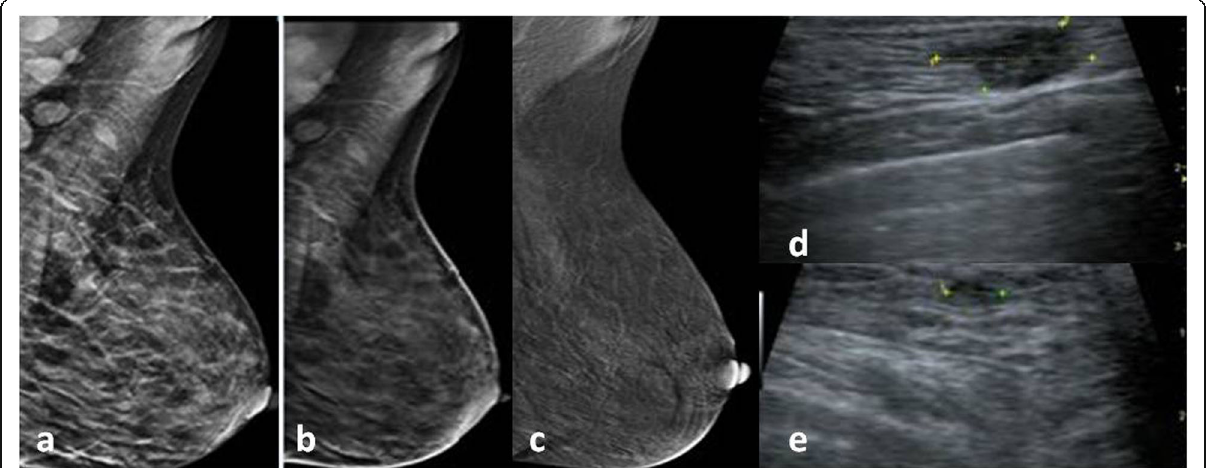
Fig. 3 A 32-year-old patient presented by a palpable lump in her left breast. Mammography and DBT revealed no abnormality ( a , b ). CEM showed no significant contrast uptake ( c ). Breast ultrasound showed an irregular ill-defined hypoechoic mass within the left breast at the axillary tail region being deeply seated over the pectoralis muscle together with adjacent another hypoechoic irregular ill-defined mass ( d , e ). The final diagnosis was invasive duct carcinoma 83%, a specificity of 48%, a positive predictive value of 68%, a negative predictive value of 68%, and a diagnostic accuracy of 68%. This was shown in Table 3.